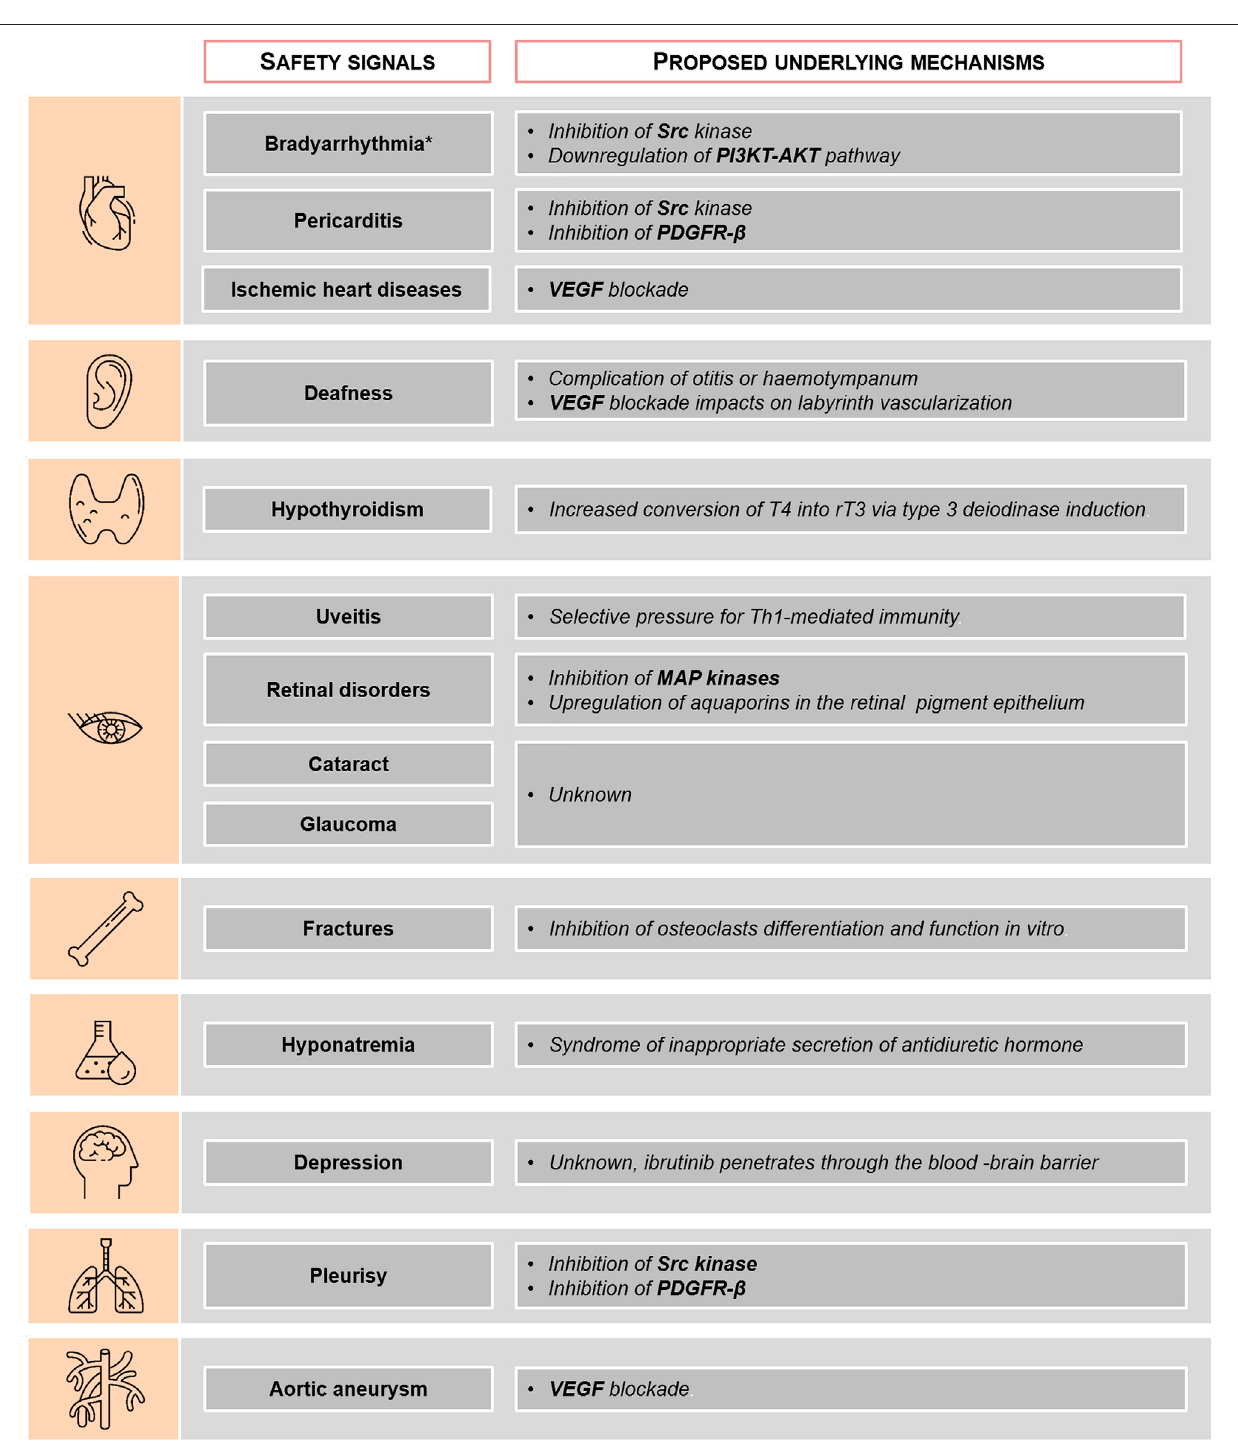
FIGURE2| Potentialunderlying mechanismsforibrutinib-associatedsafety signals.*Includingconduction defects and sinusnode functiondysfunctions.PDGFR- β , platelet derived growth factor receptor; MAP, mitogen-activated protein; PI3K, phosphoinositide 3-kinase; rT3, reverse triiodothyronine; T4, thyroxin; VEGF, vascular endothelium growth